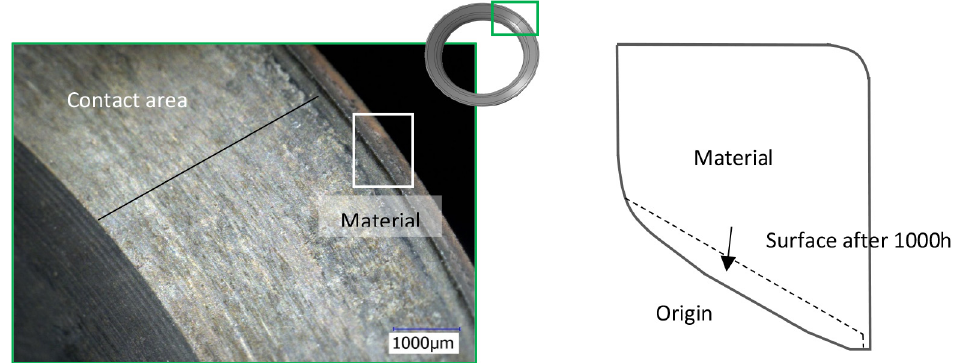
Fig. 15. Seat contact area after 1000 hours of operation.